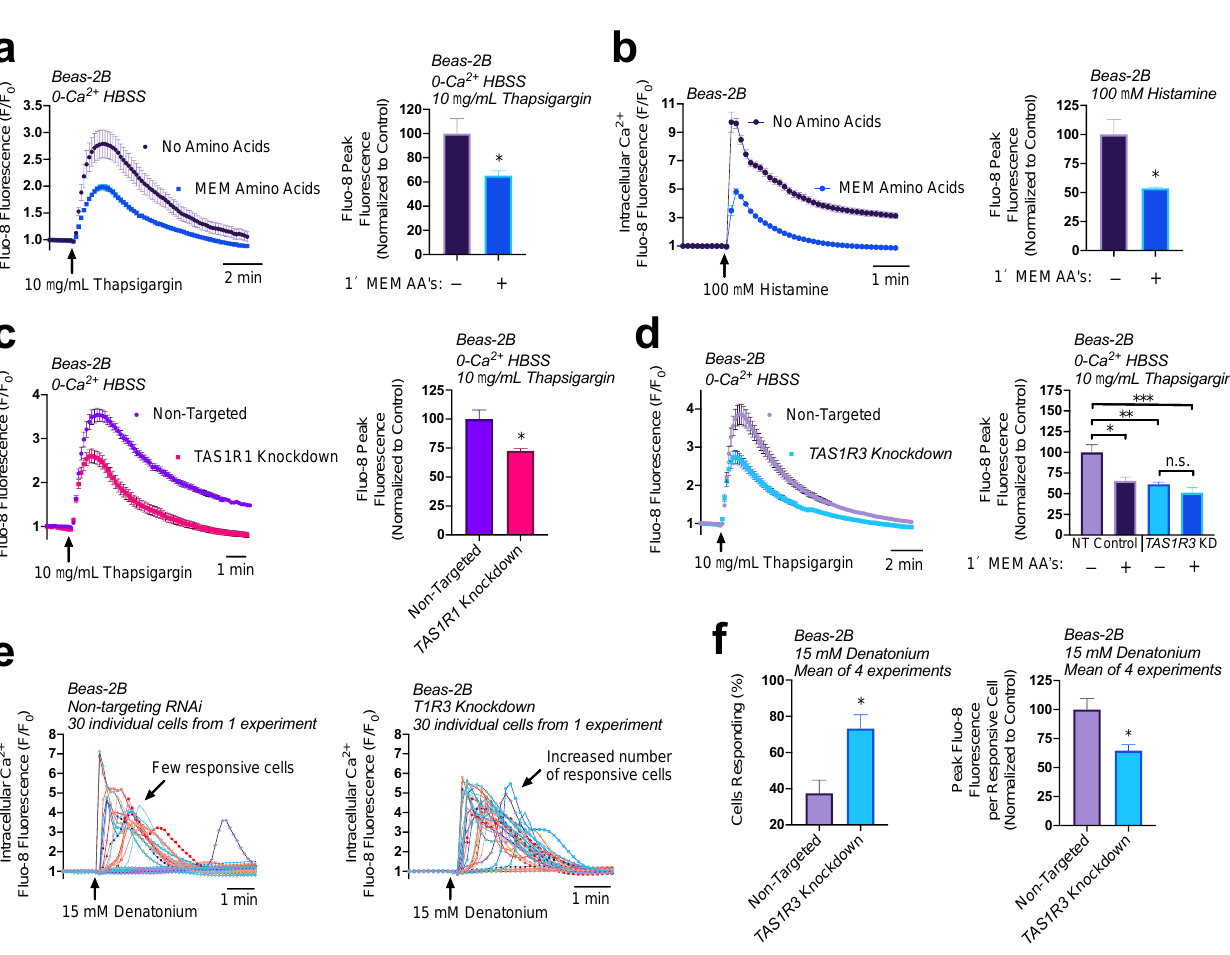
~25%. While it is paradoxical that knocking down T1R1/3 expression decreases ER Ca 2+